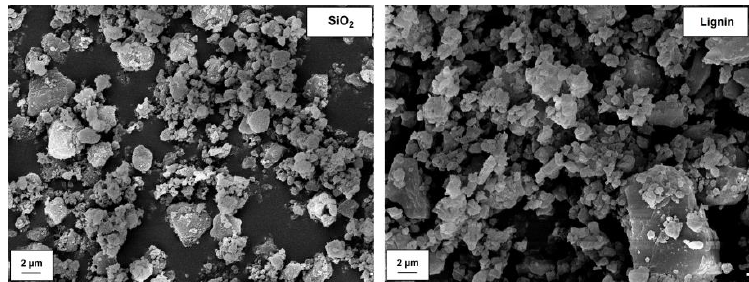
Figure 2. SEM microphotographs of pristine components (silica and lignin).